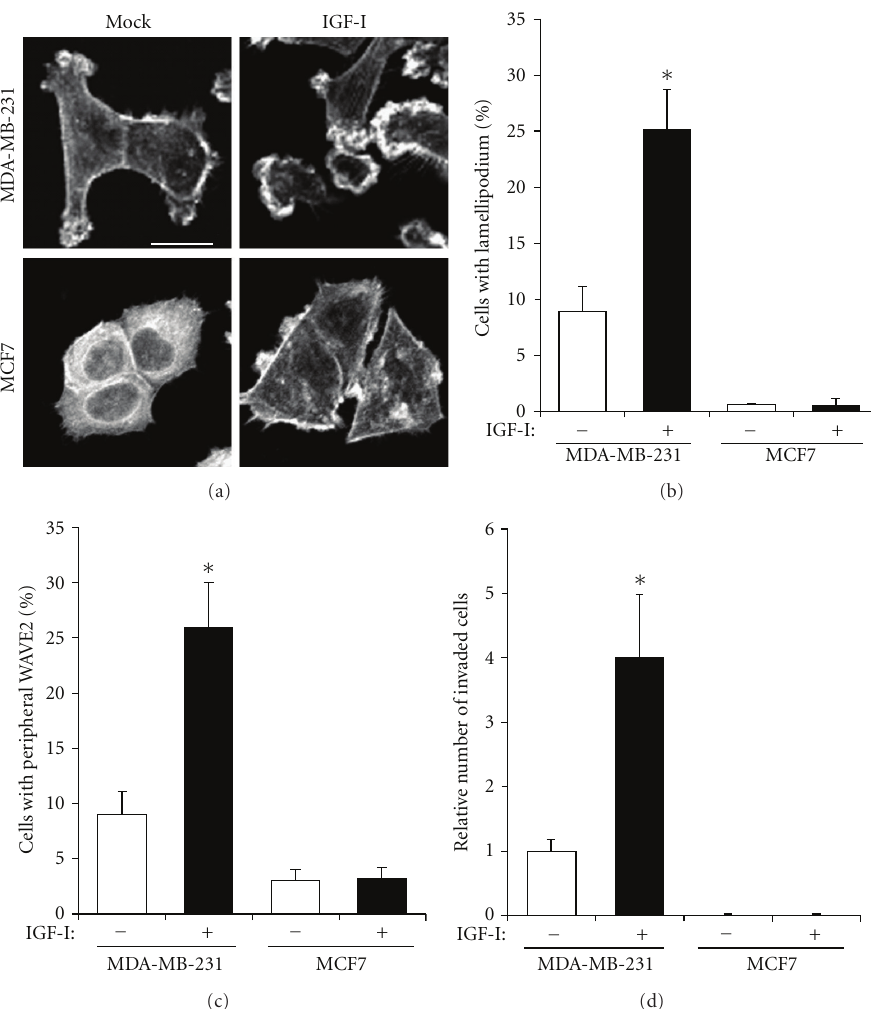
Figure 1: Induction of lamellipodia formation and invasion by IGF-I in MDA-MB-231 cells but not MCF7 cells. (a) After stimulation with (IGF-I) or without (mock) IGF-I, cells were stained with phalloidin. Scale Bar 20 μ m. (b) Cells after stimulation with (+) or without ( − ) IGF-I were stained with phalloidin, and the frequency of cells with lamellipodia was determined. The mean (SD) values of triplicate experiments are given. ∗ P < 0.003, by Student’s t -test. (c) After stimulation with (+) or without ( − ) IGF-I, cells were stained with anti-WAVE2 antibody, and the frequency of cells with peripheral WAVE2 staining was determined. The means (SD) of triplicate experiments are given. ∗ P < 0.0001. (d) After incubation of cells toward medium containing (+) or lacking ( − ) IGF-I, invaded cells were stained with Giemsa solution. The number of invaded cells relative to quiescent MDA-MB-231 cells was determined, and the mean (SD) values of triplicate experiments are given. ∗ P <